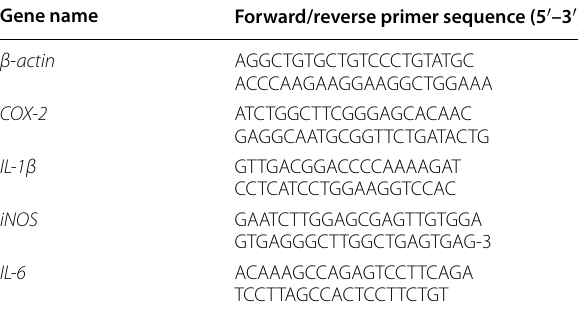
Table 1 Primer sequences used in the qPCR